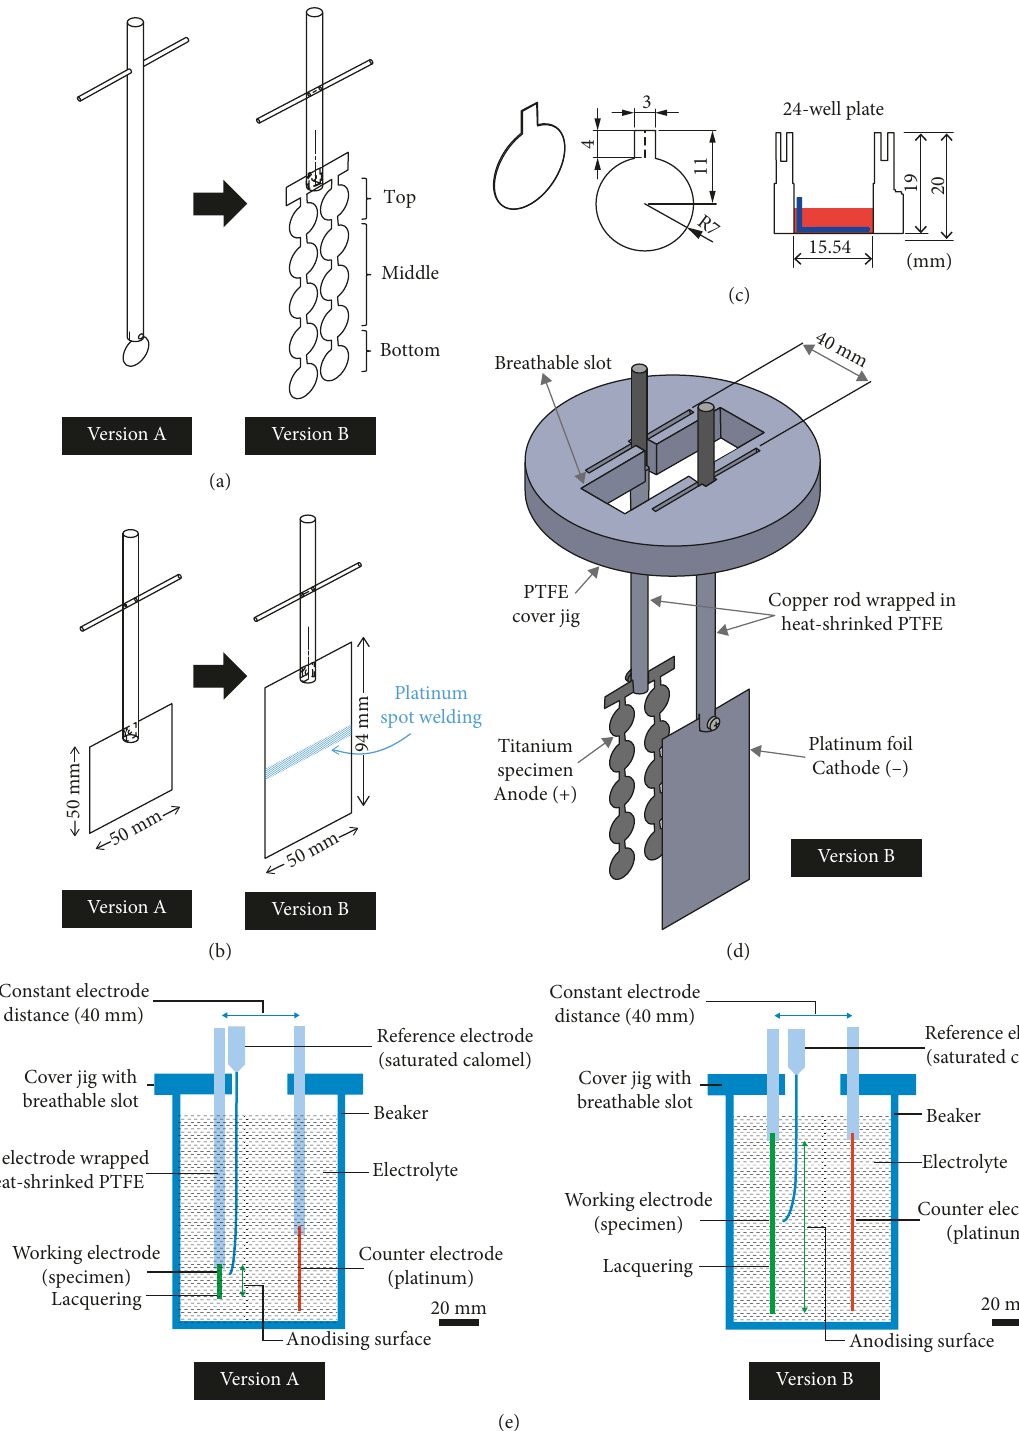
Figure 3: (a) The design optimisation of Version A to Version B with 10x increase of specimens per anodisation; (b) spot weld of two pieces of platinum foil as the size of counter-electrode should be at least, if not larger than the overall area of the working electrode; (c) the specimen shape after cut using a precision cutting device; the tag can be folded into L shape for cell and tissue culture activity; (d) full configuration of the optimised anodisation device (Version B); (e) the schematic comparison of the two versions; note that the anodising surface on Version B was dramatically increased as compared with Version